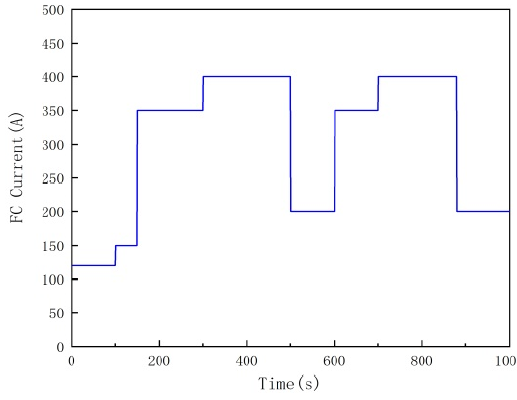
Figure 5. Loading conditions.